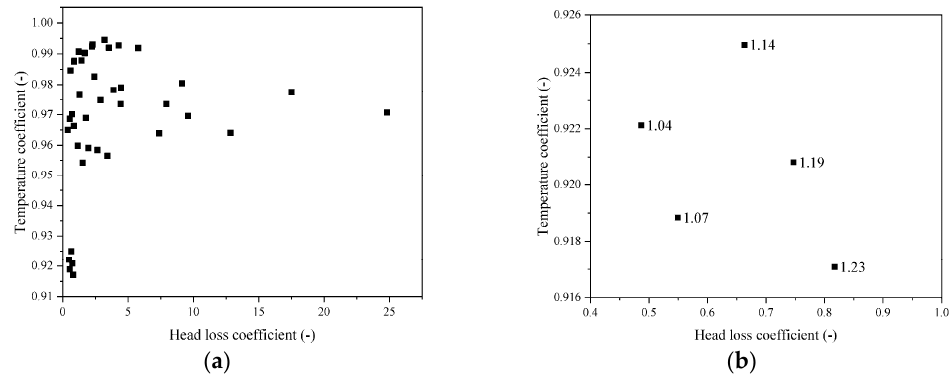
Figure 8. Simulation results ( a ) all of the solution; ( b ) 5 most favourable solutions (with vector lengths).